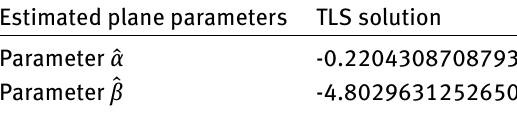
Table 9: Dataset for fitting a plane in 3D from [12] point no.